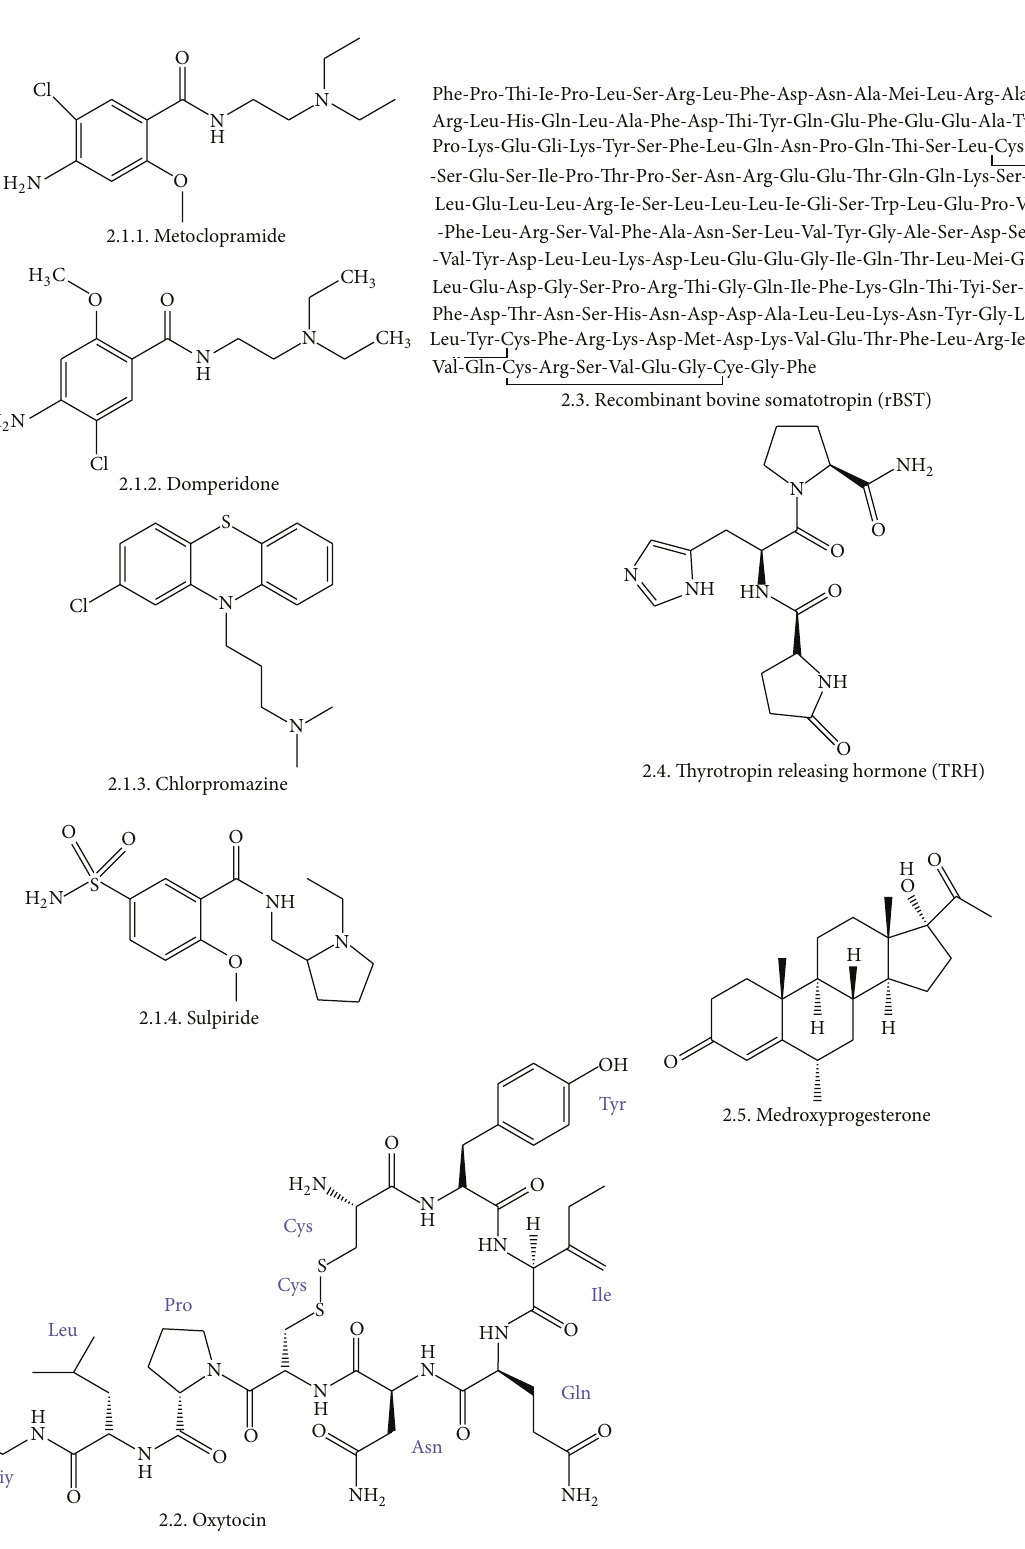
Figure 1: Synthetics galactogogue drugs